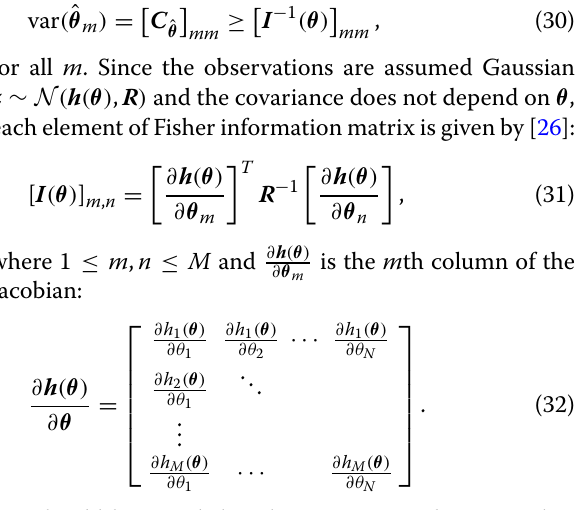
Algorithm 2 Grid initialization: N L LOS paths and N N NLOS